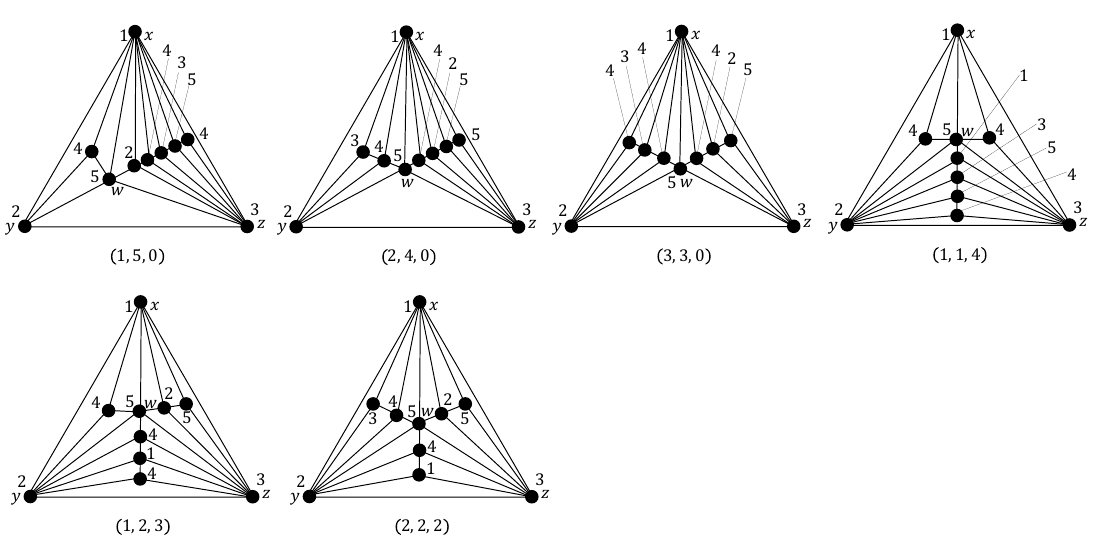
Figure 8: Facial 3-complete 5-colorings of G when G has only w